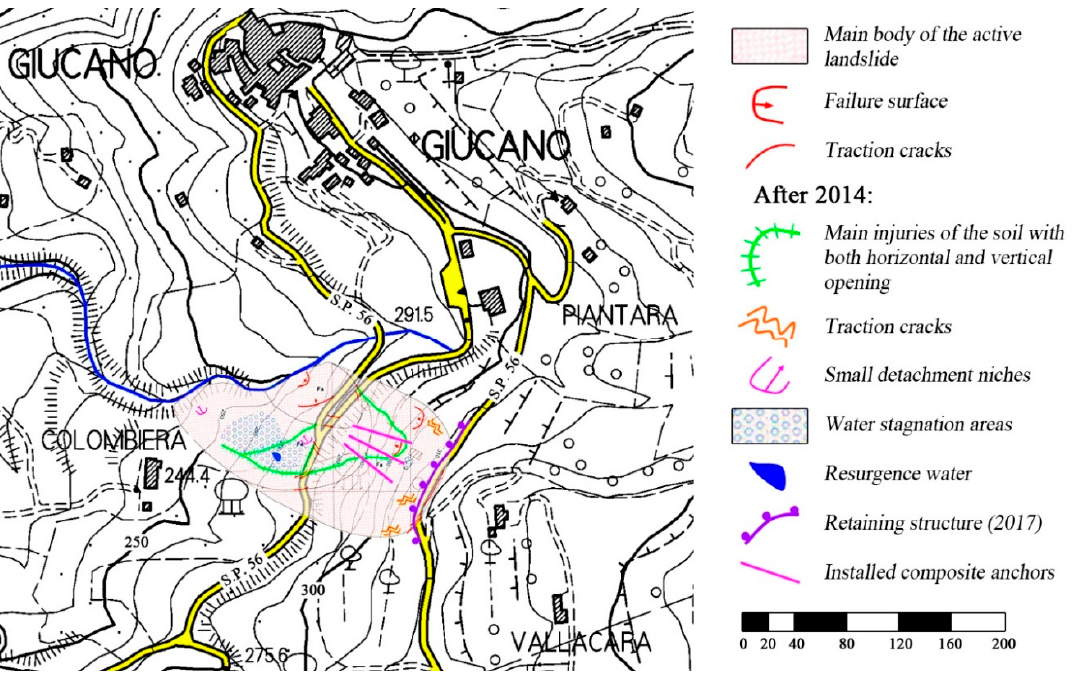
Figure 10. Map of the Giucano landslide activated in May 2013.